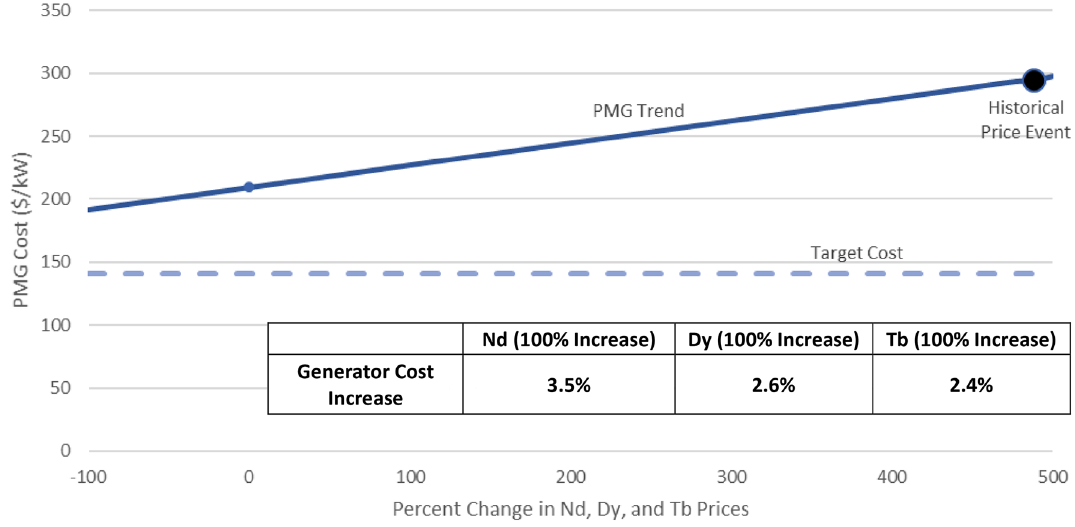
Fig. 4 Impact of permanent magnet material price changes on over- all PMG cost ($/kW). The black dot indicates the historical price event example where we show the effects of the 2011 material price